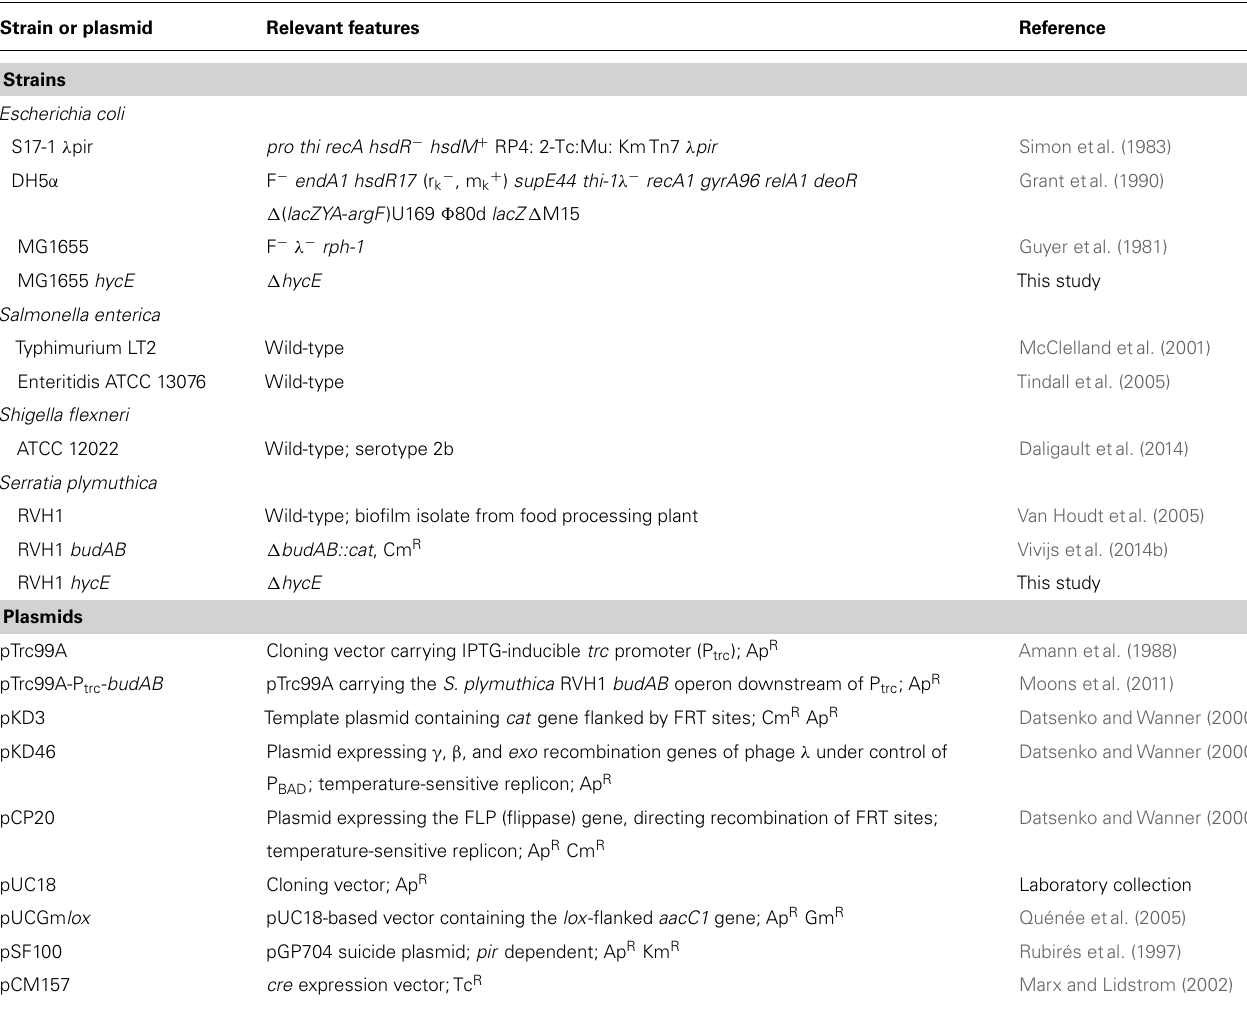
Table 1 | Strains and plasmids used in this